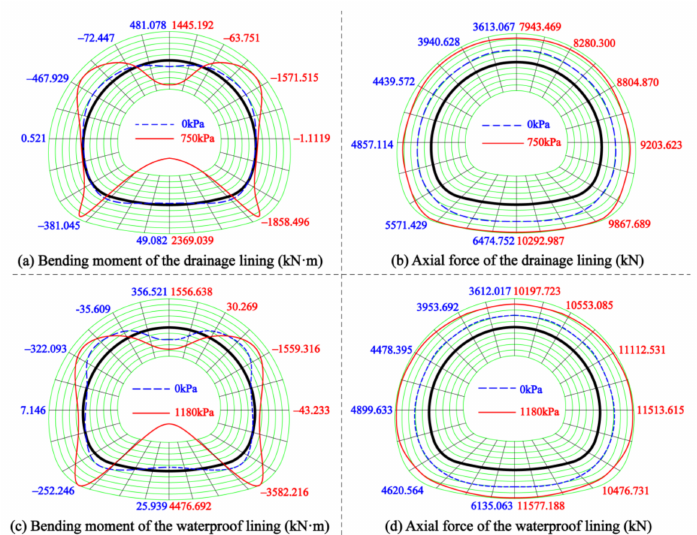
Figure 13. Distributions of the internal forces in the general stress state and ultimate failure state.